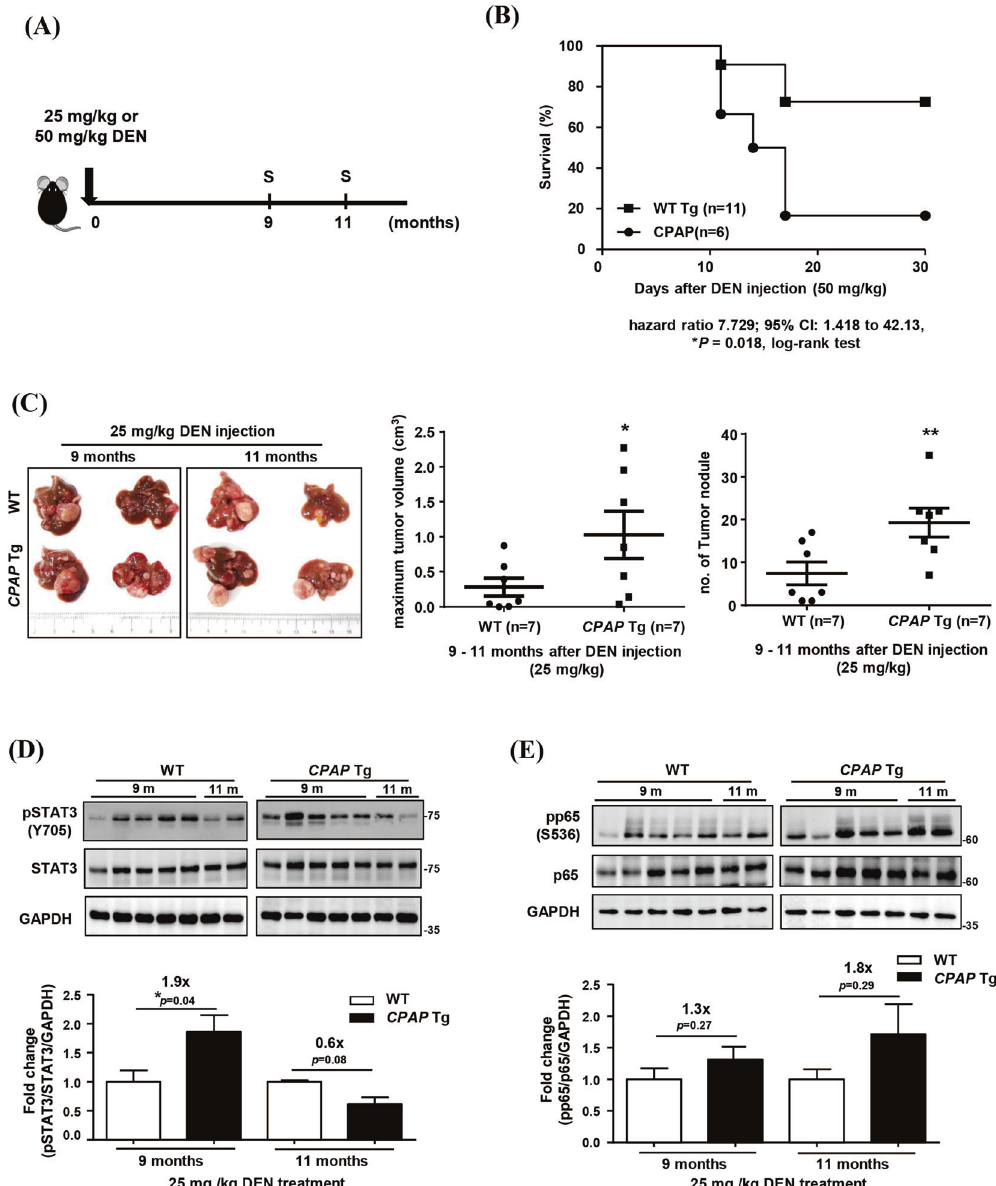
Fig. 3 CPAP enhances DEN-induced hepatic tumorigenesis. A Schematic illustration of the protocol for low-dose DEN (25 mg/kg or 50 mg/ kg) treatment in CPAP Tg and WT mice (arrow). Mice were sacri fi ced 9 and 11 months after DEN injection (S). B Survival rate of CPAP Tg ( n = 6) and WT mice ( n = 11) after 50 mg/kg DEN injection. Statistical analysis was performed using the log-rank test (Mantel-Cox method). HR = 7.729; 95% CI: 1.418 to 42.13, p = 0.018. C Representative gross images of liver tumors in WT and CPAP Tg mice 9 and 11 months after 25 mg/ kg DEN injection are shown (left); the tumor volume (middle) and nodule number (left) were determined. D , E Activation of STAT3 ( D ) and NF- κ B ( E ) in liver tissues of DEN-treated mice was evaluated as described in the legend for Fig. 2E, F. GAPDH was used as the loading control, and the quantitative results are shown. * p <